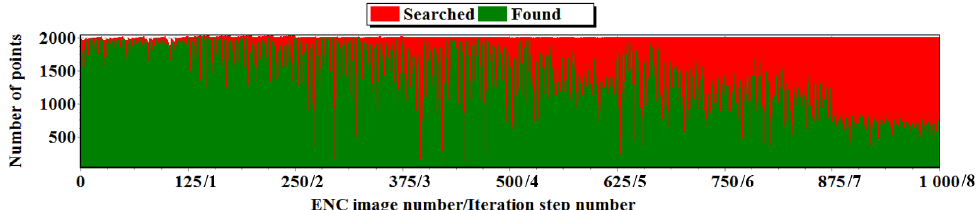
Figure 15. Graphs of the number of points in set N (“Seeking” identical points) and the number of points from set I considered identical (“found” in close proximity) during the iteration process for photograph No.